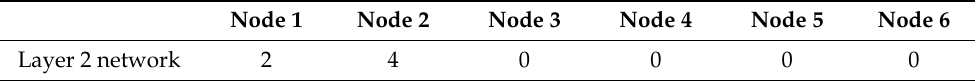
Table 8. Optimal redundancy strategy for nodes in layer 2